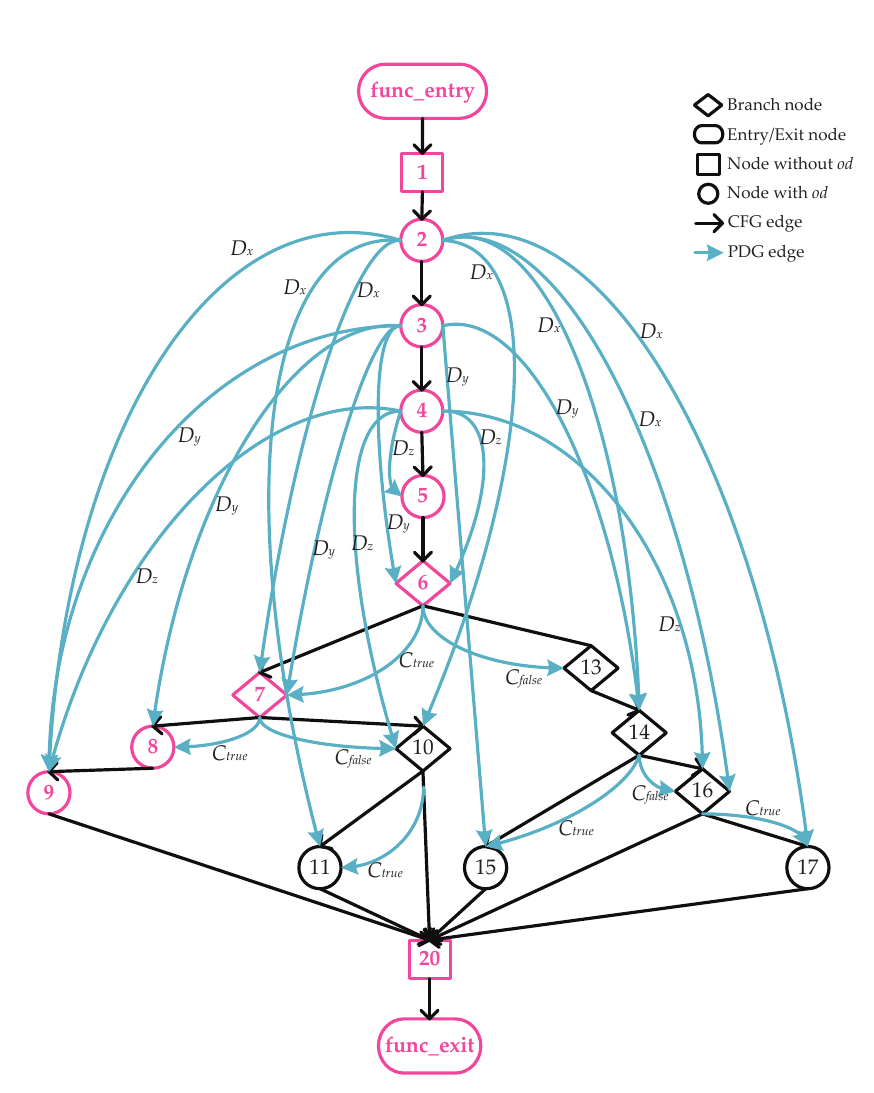
Figure 2. Simplified code property graph (CPG) of Example Function